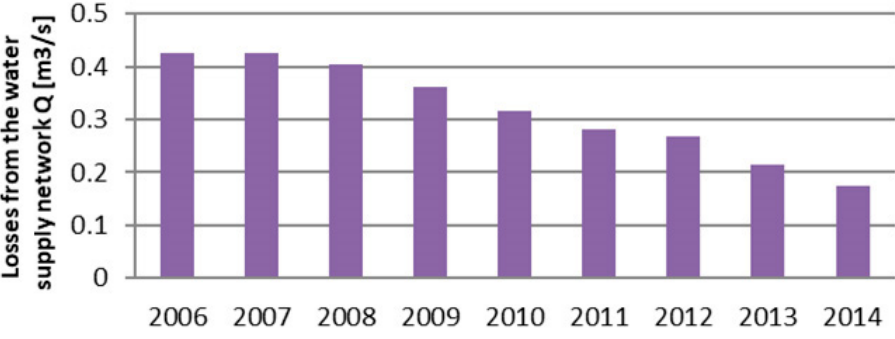
Figure 2. Losses from the water supply network in the study area (modified after [38]).